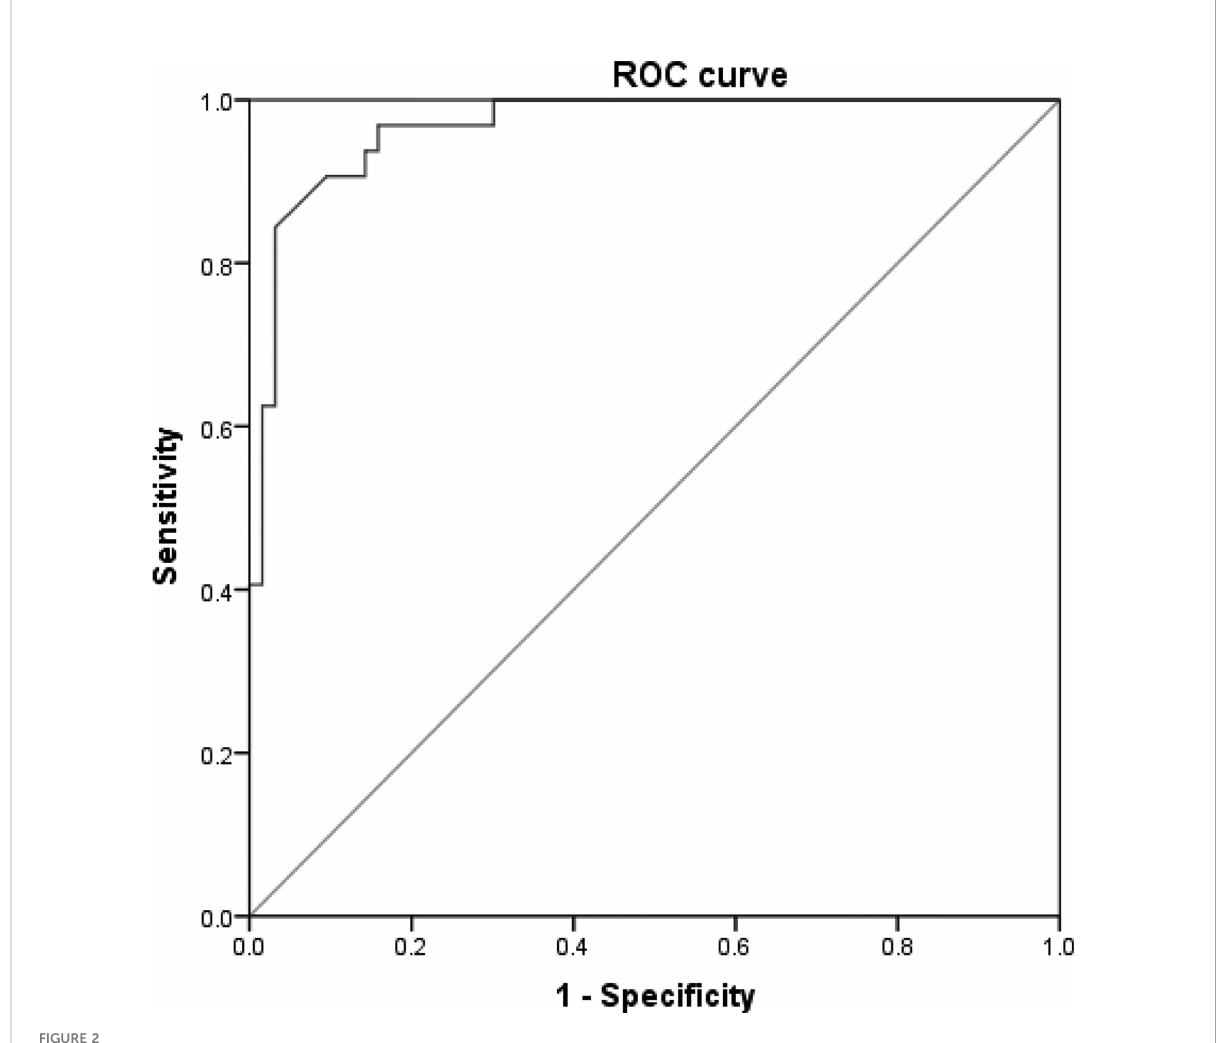
FIGURE 2 ROC curve of serum vitamin D for predicting poor sleep quality in RLS.